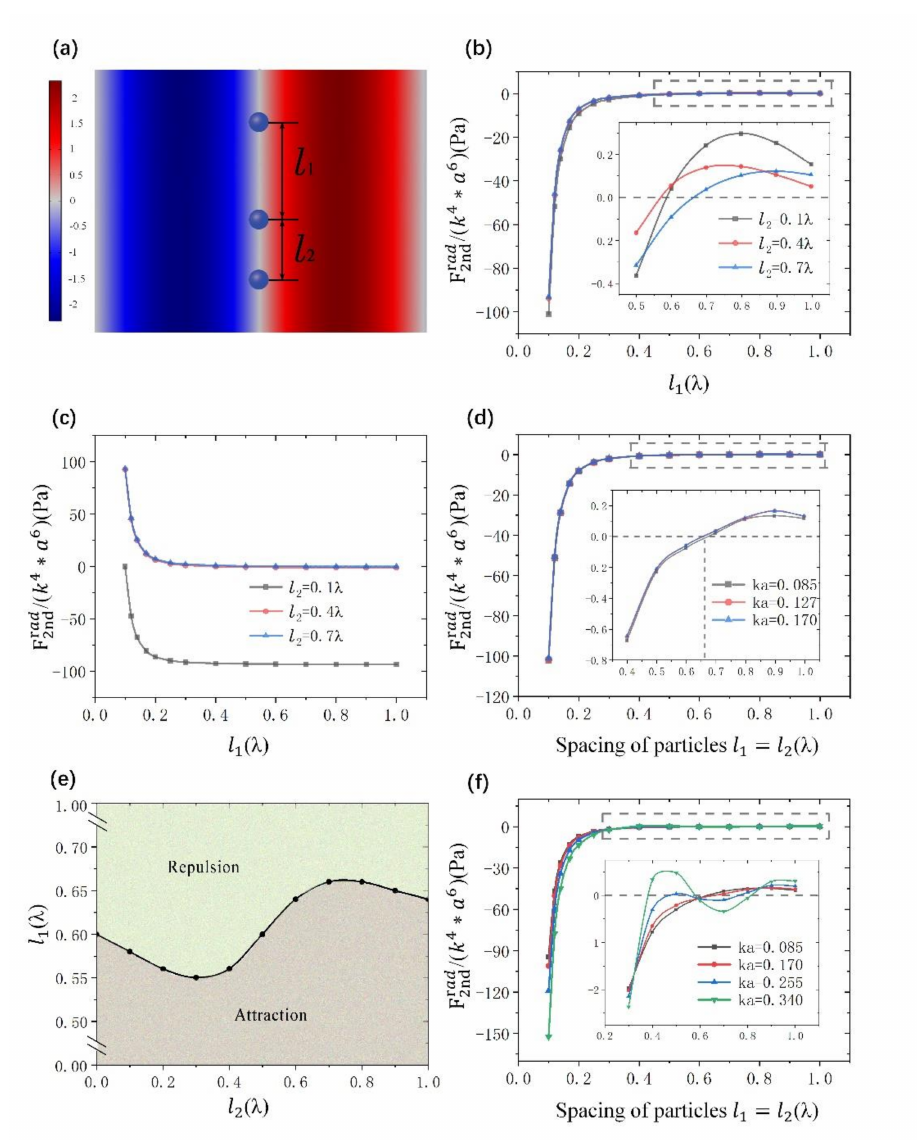
Figure 5. ( a ) Schematic for the interaction of three identical particles located at the pressure node; ( b ) The normalized secondary ARF on the upper sphere with ka = 0.170; ( c ) The normalized secondary ARF acting on the middle sphere with ka = 0.170; ( d ) E ff ects of ka on the secondary ARF of three equidistant spheres; ( e ) Phase diagram of the secondary ARF acting on the upper sphere; ( f ) E ff ect of the lower particle radius on the secondary ARF of the upper